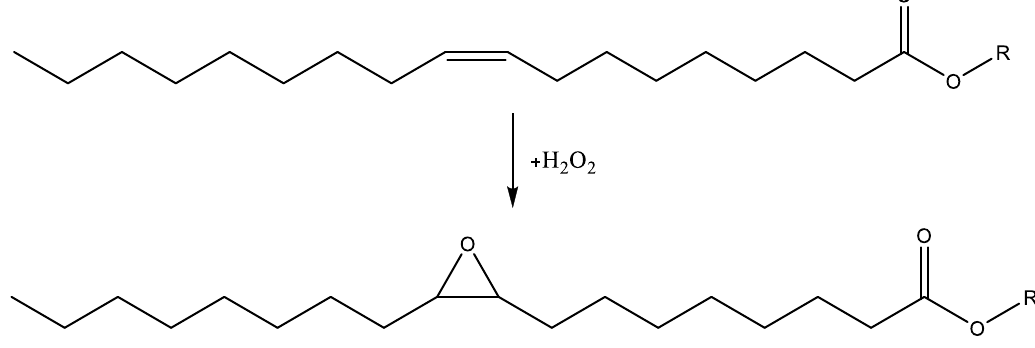
Figure 10. Synthesis of epoxidized methyl oleate (R=CH 3 ) and epoxidized oleic acid (R=H).